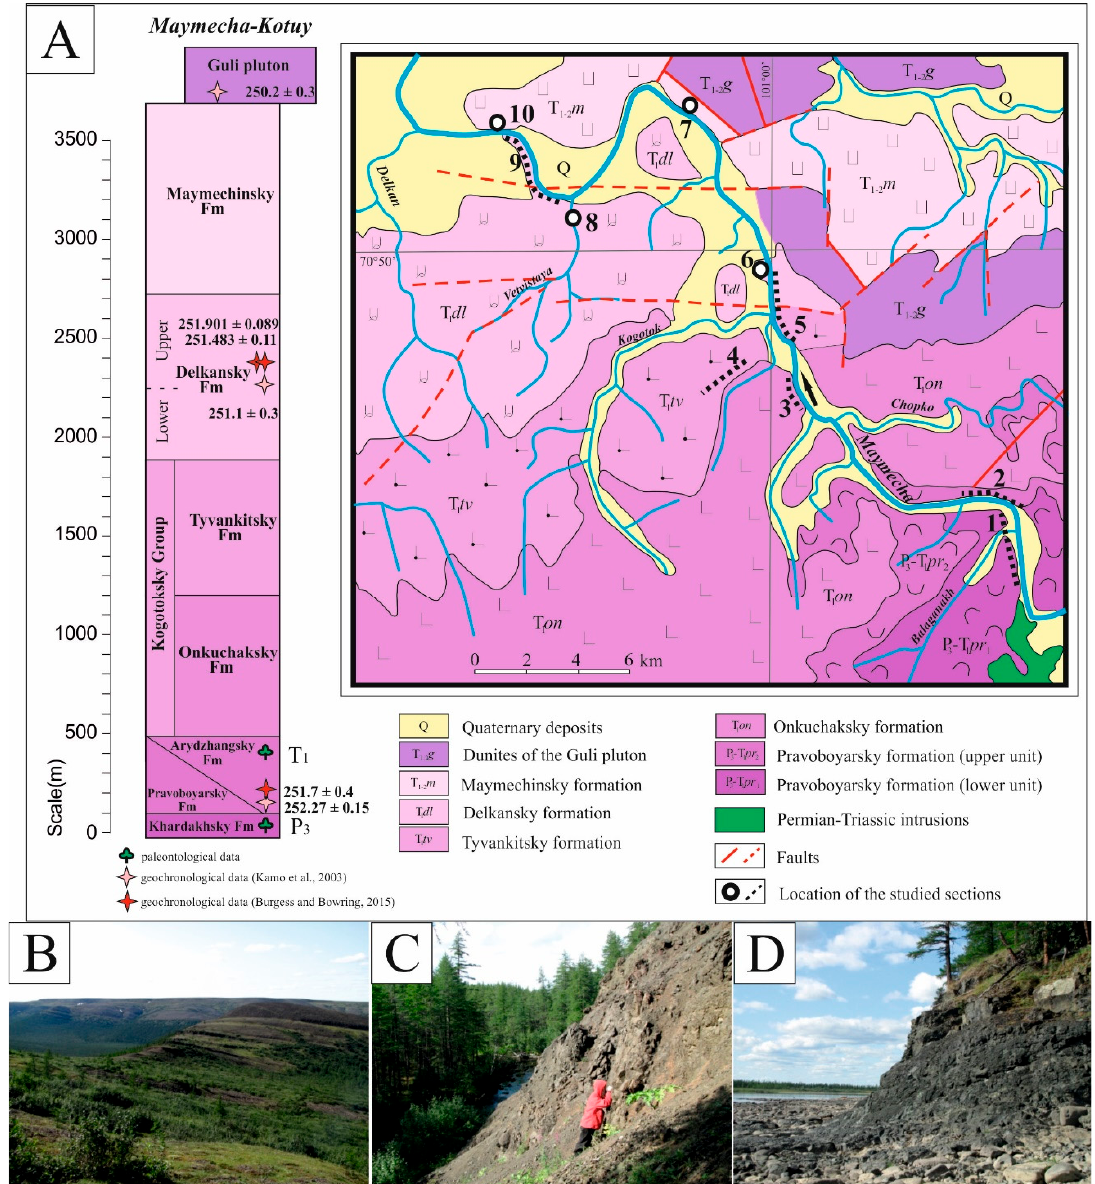
Figure 2. ( А ) Sketch geological map of the Maymecha river valley and the stratigraphic column of the Permian-Triassic volcanic rocks of the Maymecha-Kotuy region. ( B ) Lava flows of the Tyvankitsky Formation, profile 4. ( C ) Outcrops of the Upper Delkansky Formation lavas, the Vetvistaya river, location 8. ( D ) Outcrops of the Maymechinsky Formation, location 10.